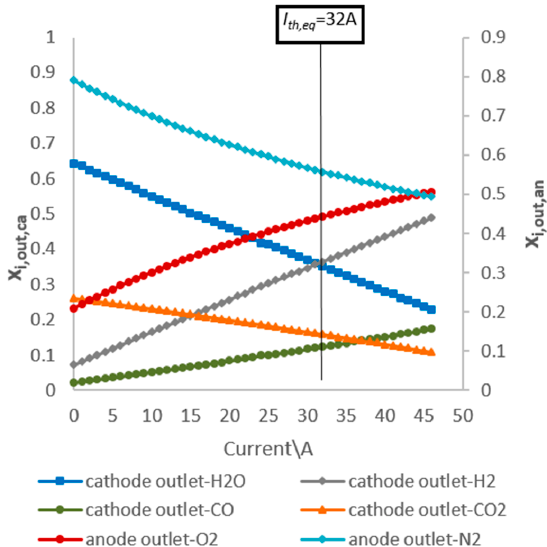
Figure 11. Trends of anode and cathode exhaust gas composition for the SOE stack fed the steam-CO 2 mixture and by air at varying the stack